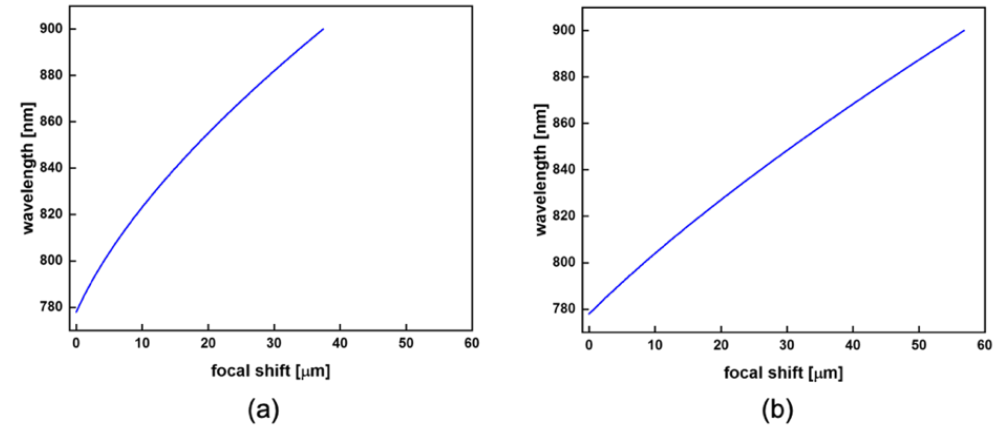
Figure 3. Chromatic focal shift calculated for ( a ) the ADL and ( b ) the TFL.